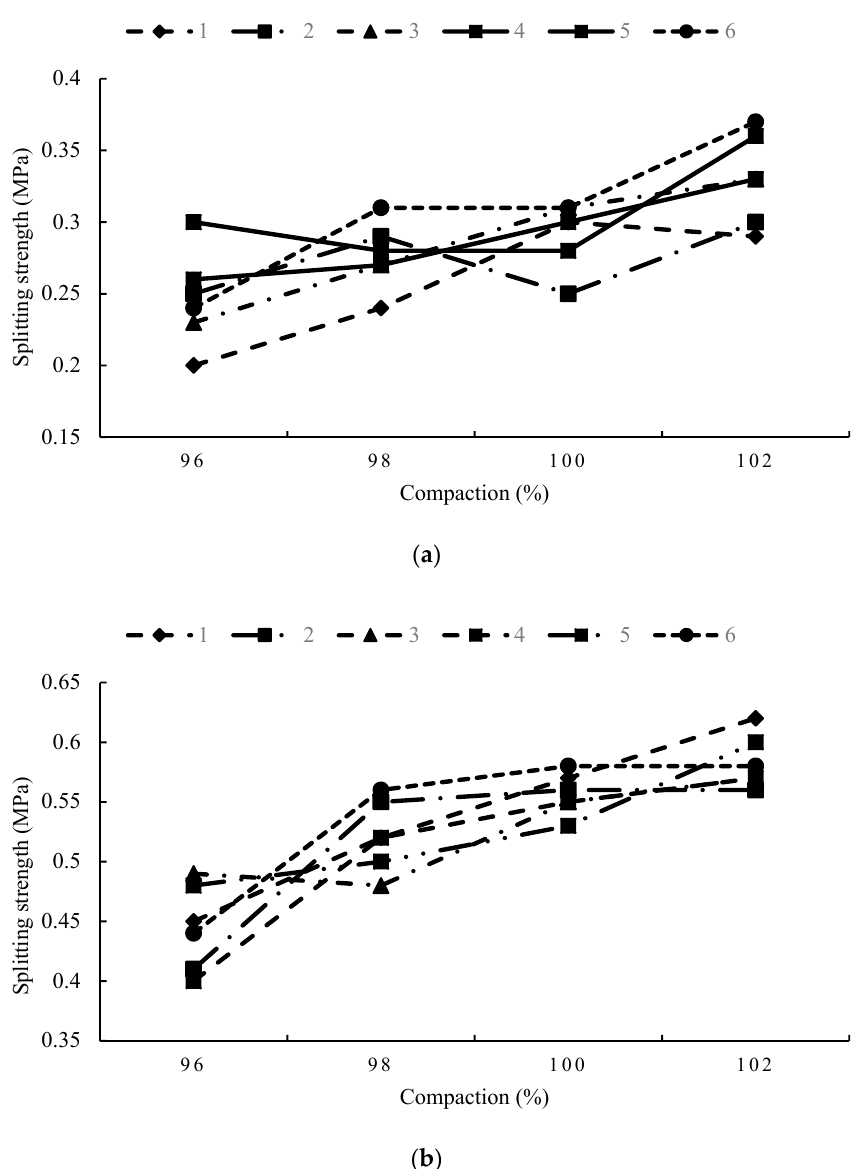
Figure 2. Splitting strength under different test procedures: ( a ) Relationship between compaction and splitting strength after 7 days of curing; ( b ) relationship between compaction and splitting strength after 28 days of curing.